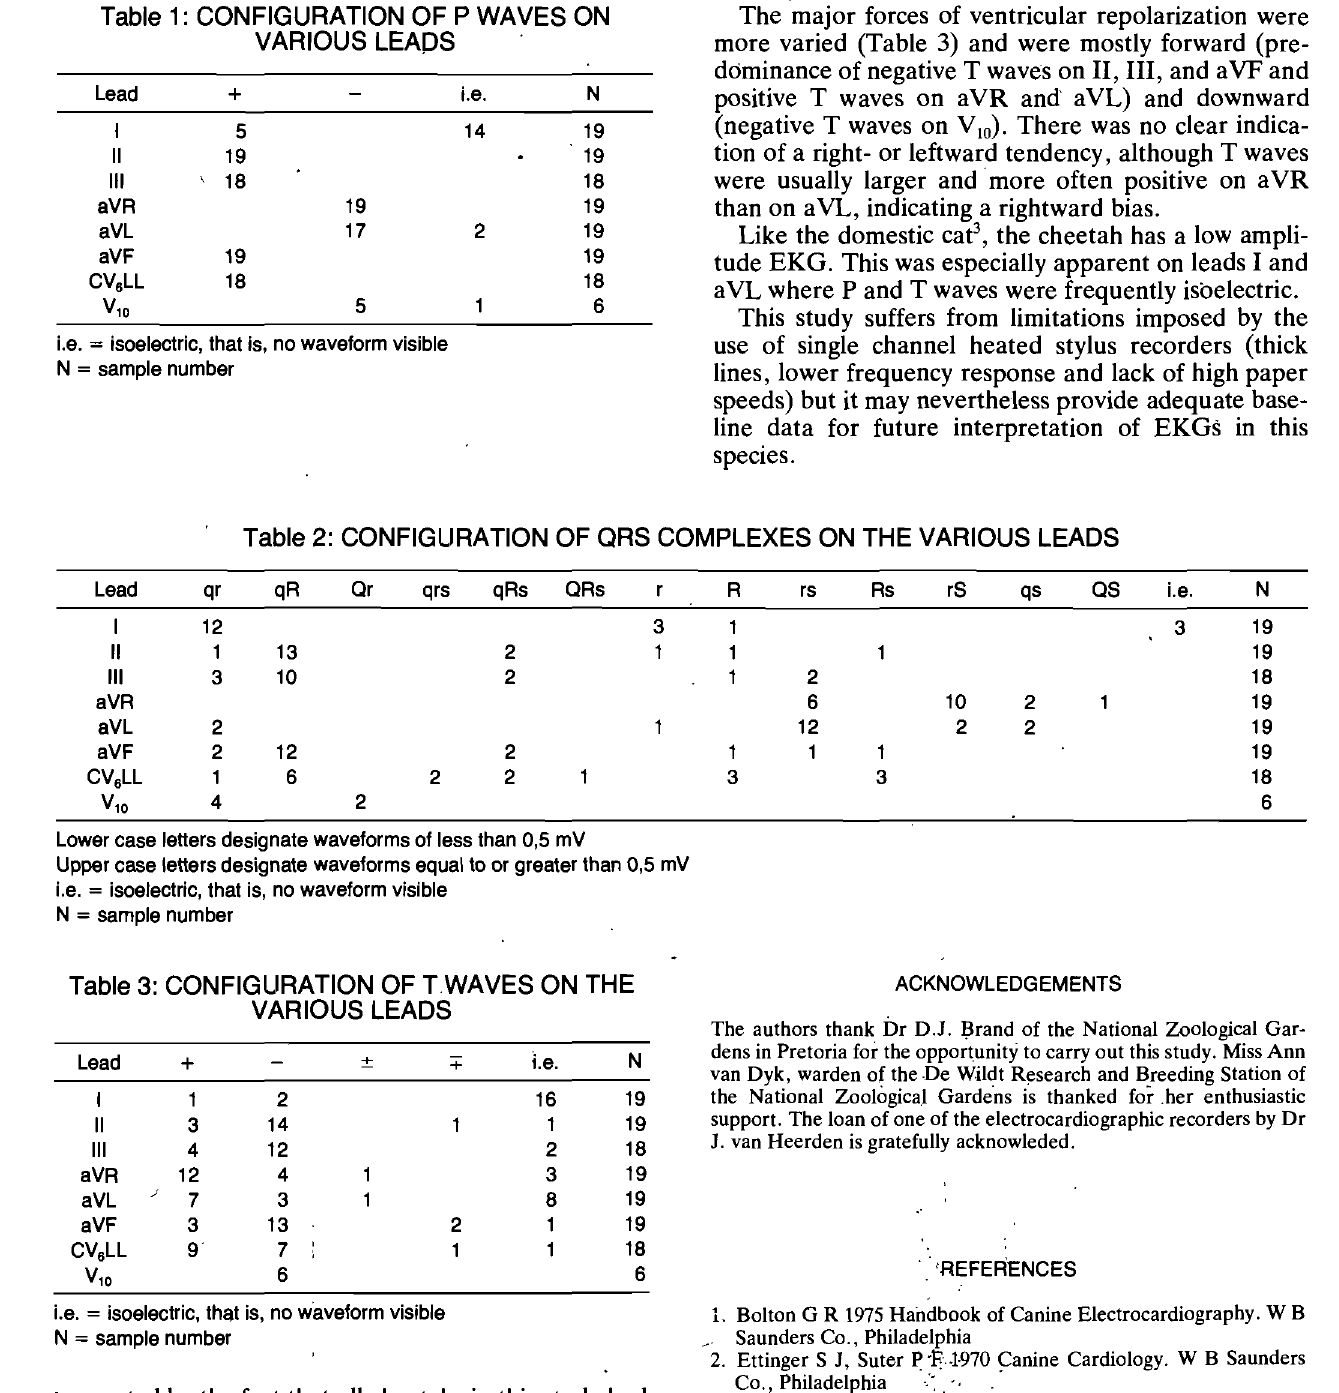
Table 3: CONFIGURATION OF TWAVES ON THE VARIOUS